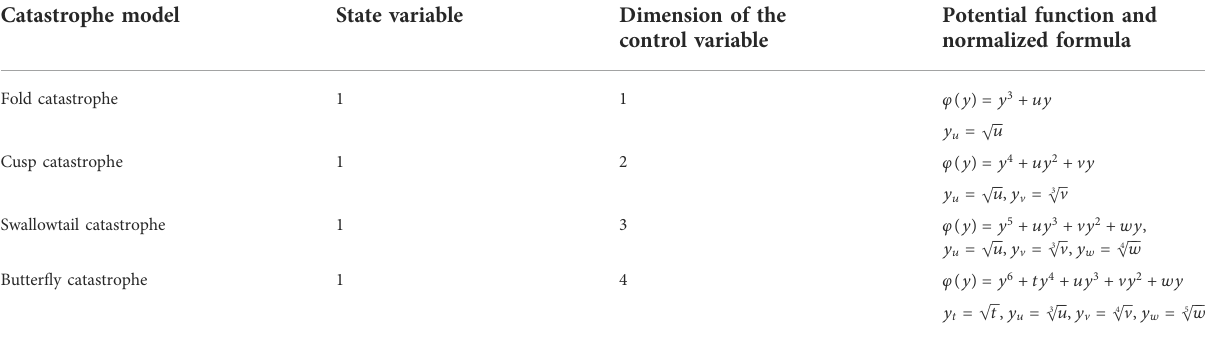
TABLE 2 Four common catastrophe models and normalized